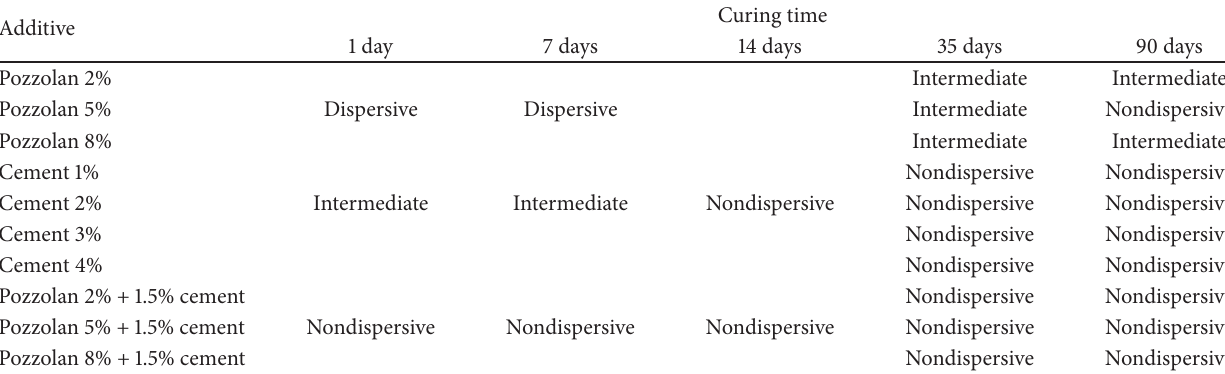
Table 4: Categorization based on chemical test results of clay sample stabilized with pozzolan, cement, and pozzolan plus 1.5 percent cement.